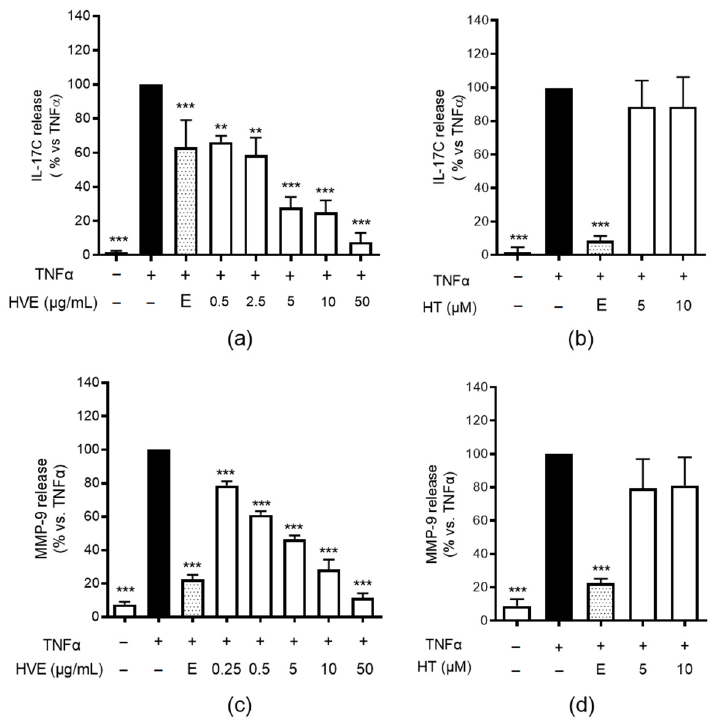
Figure 1. The effect of HVE and HT treatment (24 h) on the release of IL-17C ( a , b ) and MMP-9 ( c , d ) by HaCaT cells challenged by TNF- α (10 ng/mL), measured by the ELISA assay. HT was not effective until the highest concentration tested (10 μ M corresponding to 4.93 μ g/mL). The data are expressed in percentages, relative to the stimulated control, which is arbitrarily assigned a value of 100%. ** p < 0.01, *** p < 0.001 versus stimulus. HVE, Hamamelis virginiana bark extract; reference inhibitor: E, epigallocatechin gallate (20 μ M).